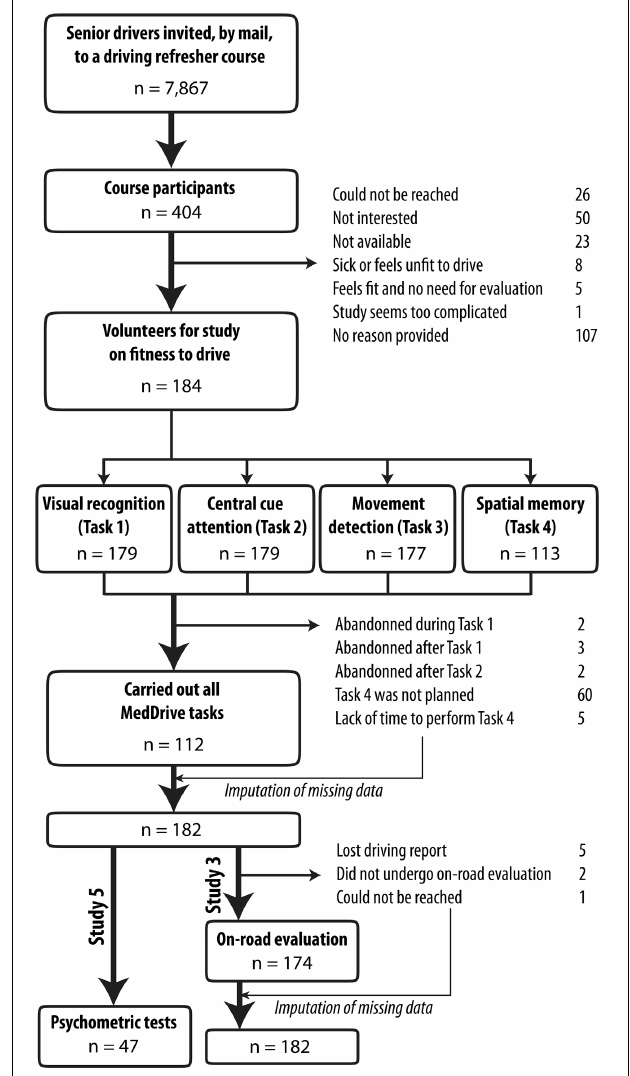
FIGURE 2 | Flow chart for selection of older drivers for studies 3 and 5. Participants were volunteers from a driving refresher course. Close to one senior driver out of two (45.5%) agreed to participate. n, sample